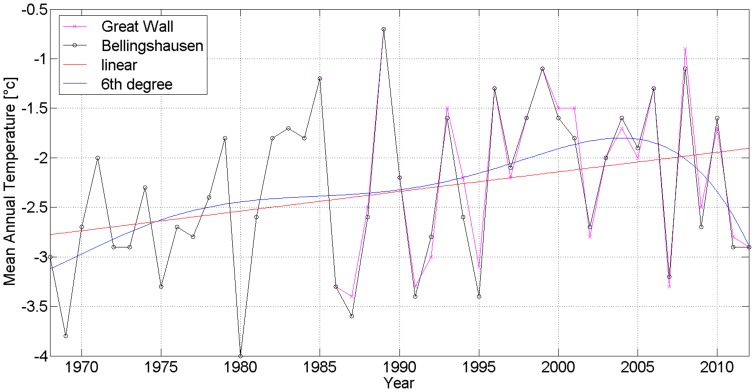
The mean annual temperature at Station Bellingshausen and Great Wall Station on Fildes Peninsula, Antarctica, by using MATLAB and calculating with linear and 6th degree [55], [56].